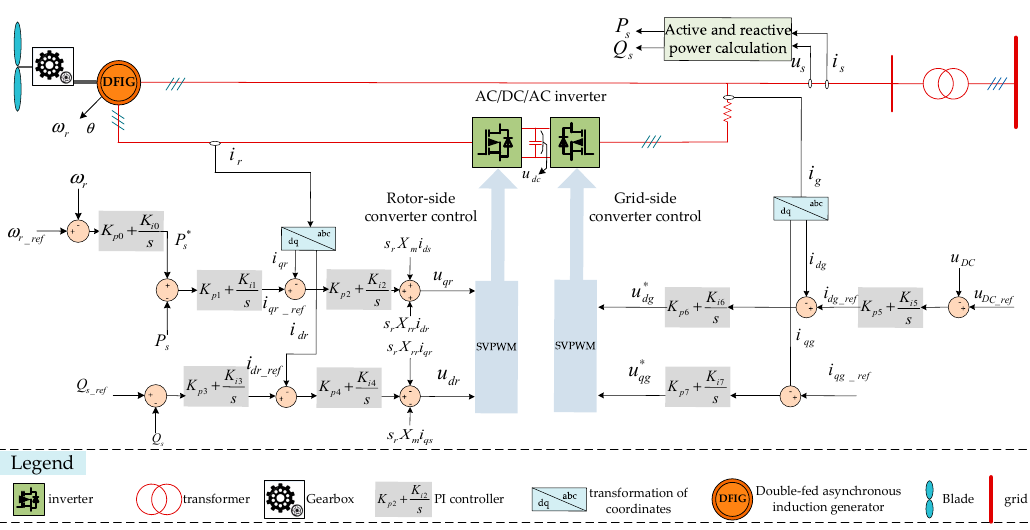
Figure 1. The structure of grid-connected DFIG system. Subscript s and r is the mark of the stator side parameter and the rotor side respectively. Subscript g is the mark of the grid side parameter. Subscript d and q is the mark of d axis parameter and q axis respectively.